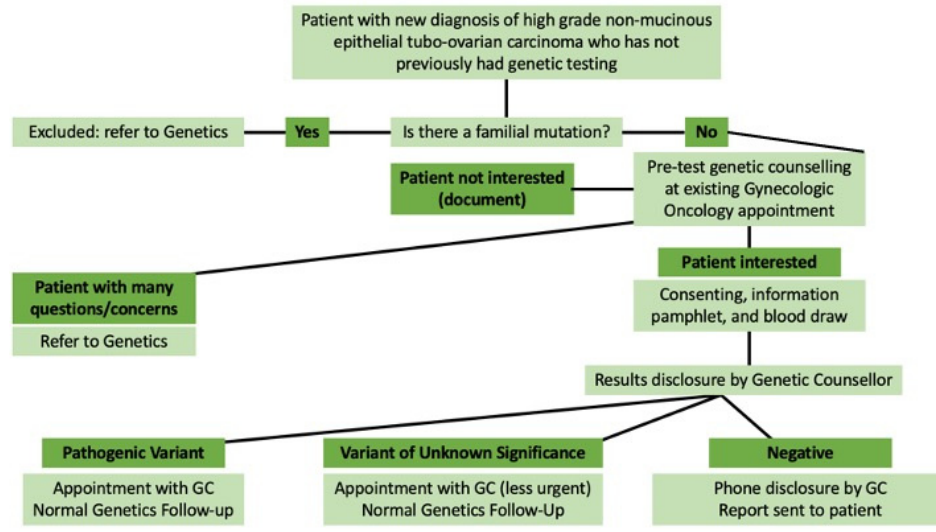
Figure 1. Gynecologic Oncology-Initiated Genetic Testing (GOIGT) Model .